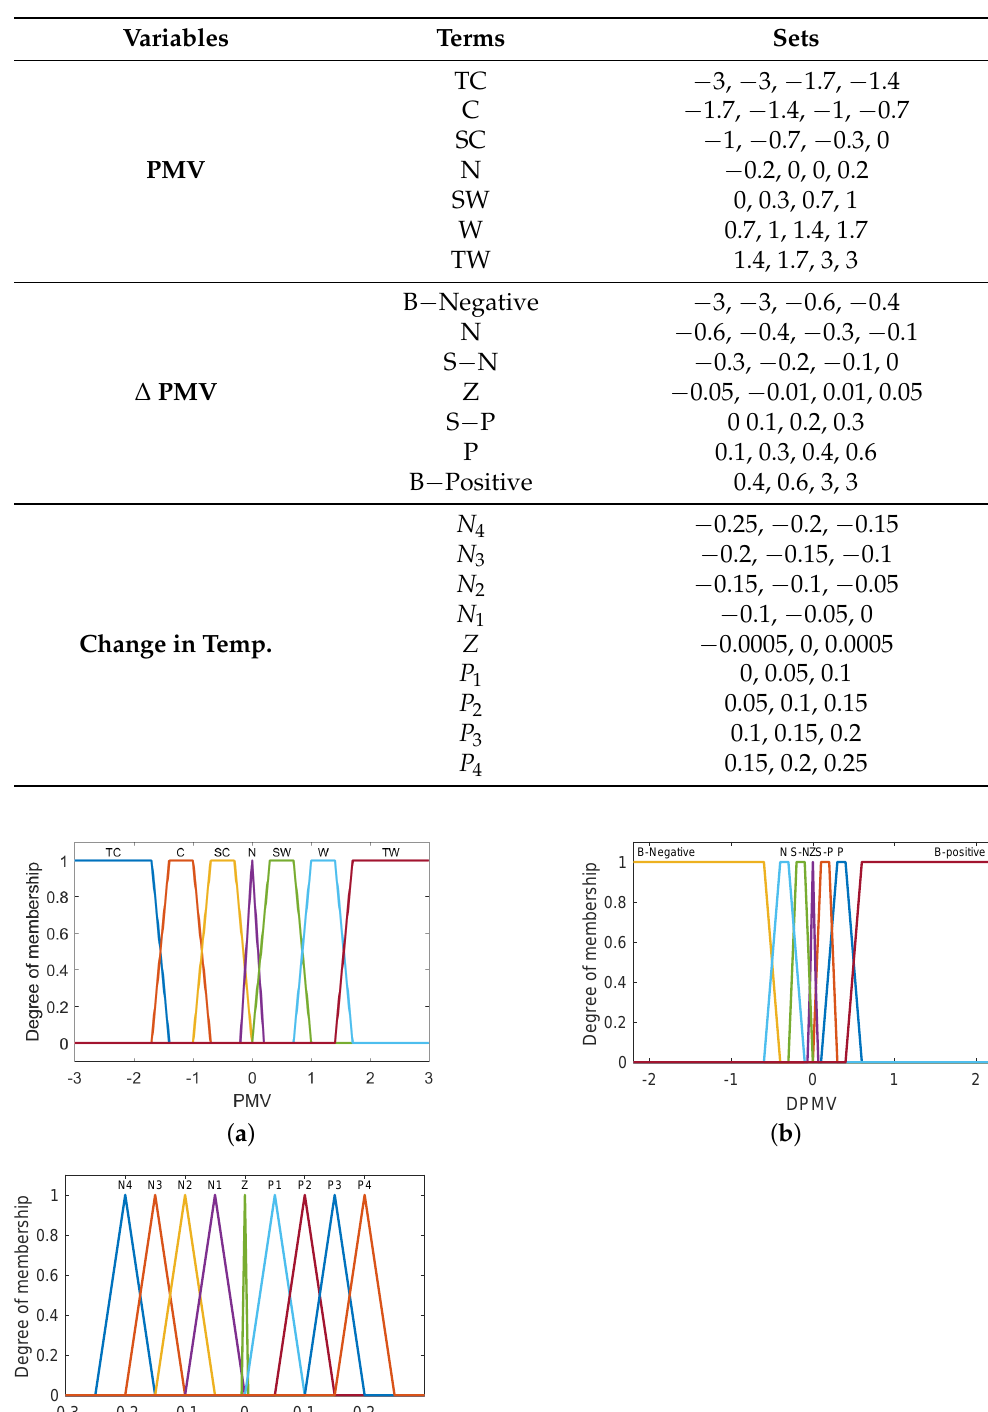
Table 2. Fuzzy sets of the fuzzy heating control in terms of input (PMV ranges from too cold to too warm, ∆ PMV ranges from Big − negative to Big positive) and output (Change in Temp. ranges from negative ( N 4 ) to positive ( P 4 )) variables.